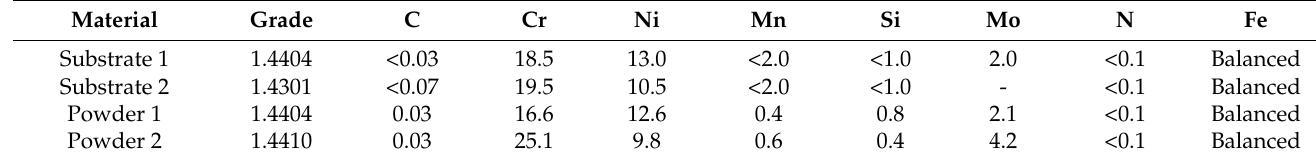
Table 1. Chemical compositions of substrate and powder in wt% (1.4404)